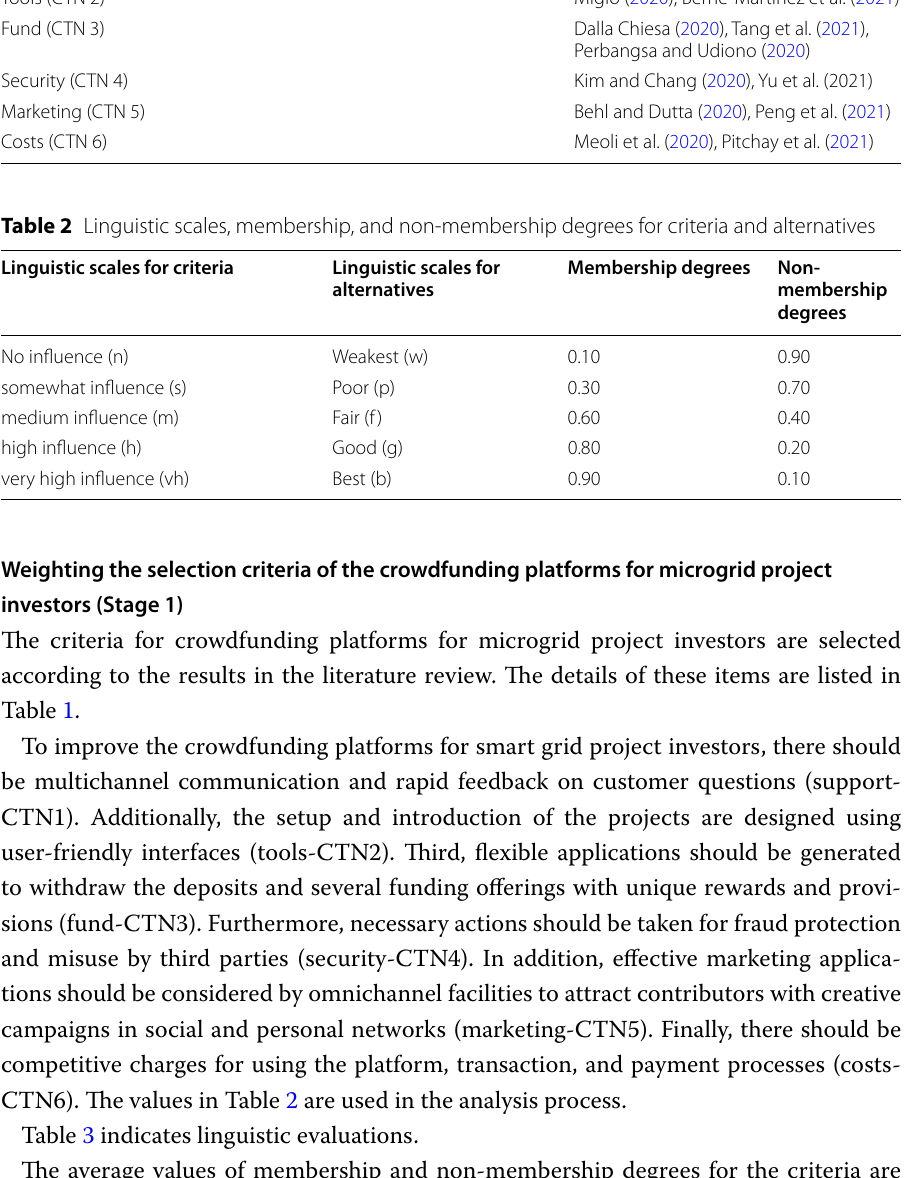
Table 3 indicates linguistic evaluations.